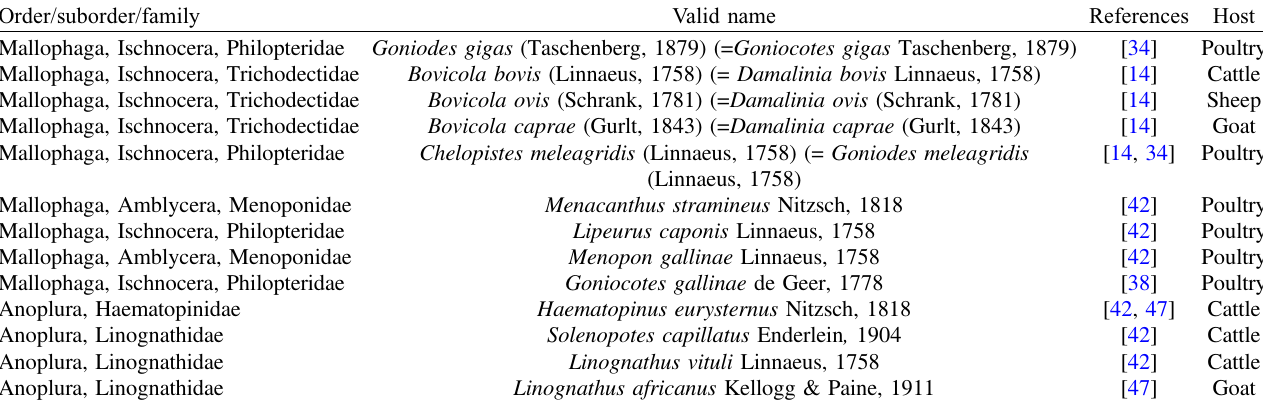
Table 5. Hosts and distribution of lice in the orders Mallophaga and Anoplura.